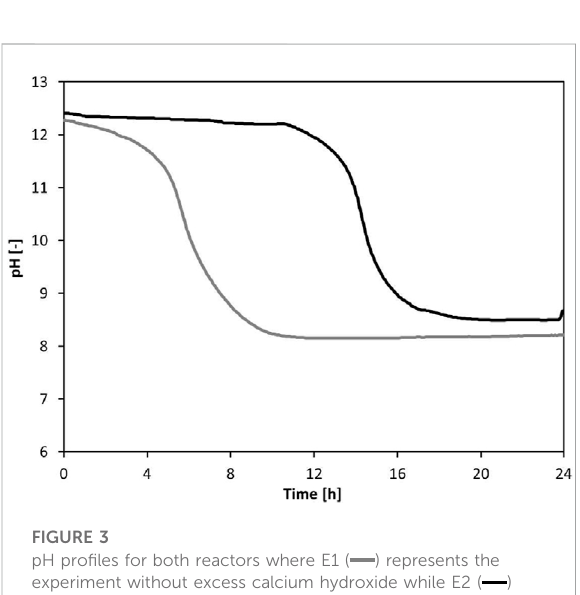
pH pro fi les for both reactors where E1 ( ) represents the experiment without excess calcium hydroxide while E2 ( ) represents the experiment with excess calcium